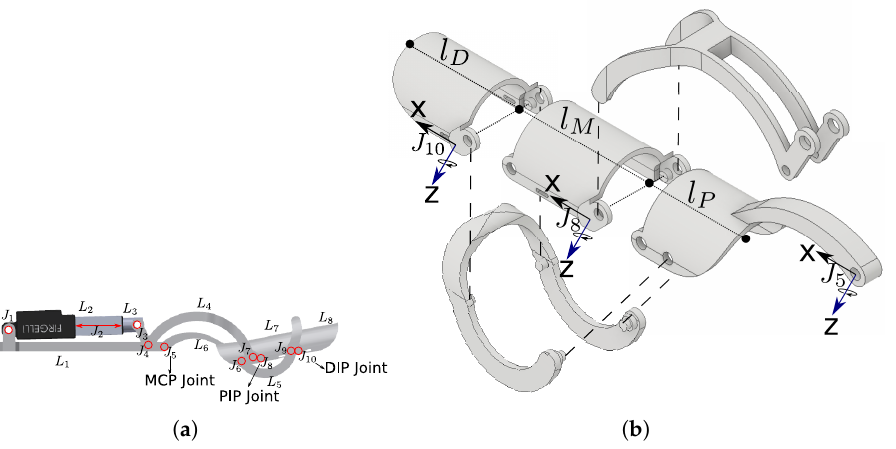
Figure 1. The exoskeleton mechanics for one finger. ( a ) Mechanical structure with a single active DOF, 8-bar, and 10-joint linkage to drive each finger in fully extended and closed configurations. ( b ) Mechanical parts and kinematic frames following the Denavit–Hartenberg (DH)